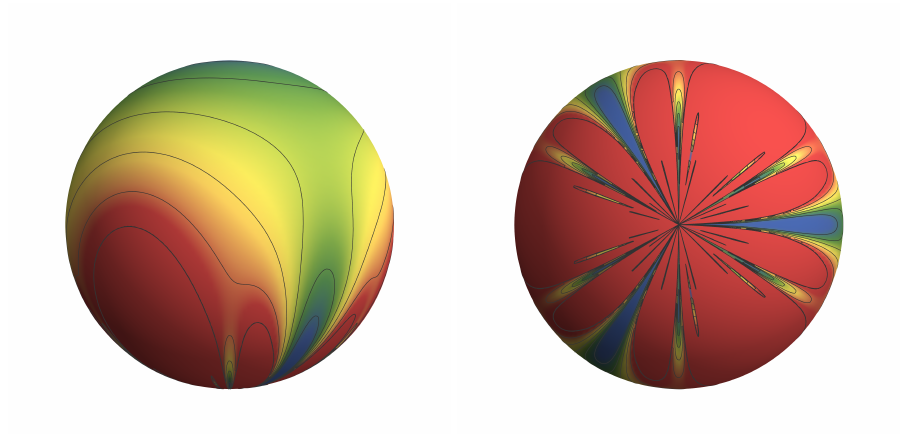
Figure 7. The whole sphere mapping of ¯ D onto S 2 (see text for the equations of the map). The mapping is that of the centered polygonal lacunary function shown in Figure 1 under ˆ S . Two different viewpoints ( 3 ) ( φ , θ ) | ) are shown. The left panel shows a “front” view such that the north of the same function ( | f 16 pole ( 0,0,1 ) is located directly on top and the south pole ( 0,0, − 1 ) directly on the bottom. The right panel shows the “bottom” view such that the south pole is directly in the center of the image. The unit circle maps to the single point at the south pole.